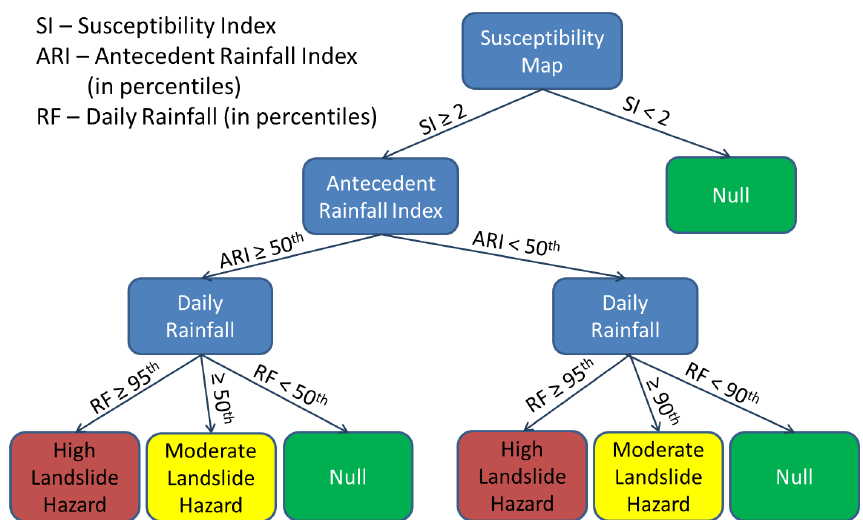
Figure 6. Decision tree structure highlighting the three tiers of decisions made in this model on a pixel-by-pixel basis across the study area, which is computed daily. First, if a pixel has an SI ≥ 2, the antecedent rainfall index (ARI) is considered using the 50th percentile value. If the ARI ≥ 50th percentile, a nowcast is issued if the daily rainfall exceeds the 50th percentile (moderate hazard) or 95th percentile (high hazard). If the ARI < 50th percentile, a nowcast is issued if the daily rainfall exceeds the 90th percentile (moderate hazard) or 95th percentile (high hazard). In all other cases, there is no nowcast issued